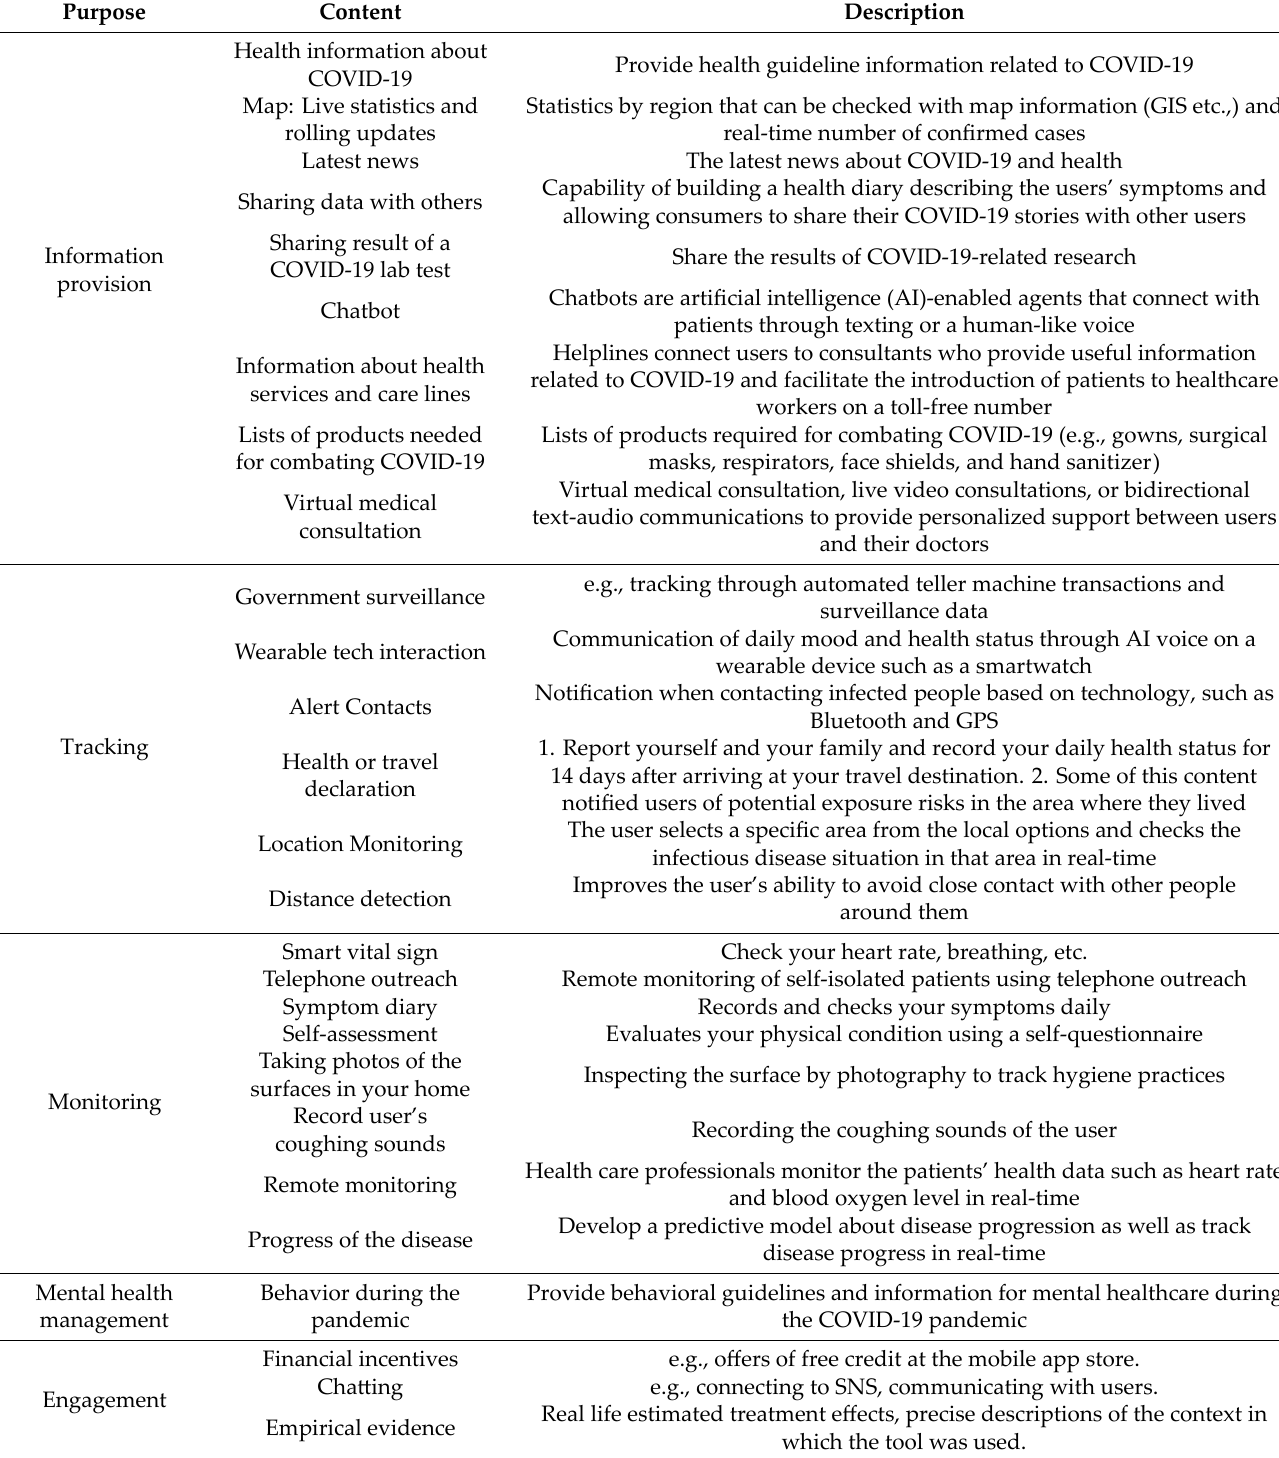
Table 1. Overview of the COVID‑19 apps from the literature